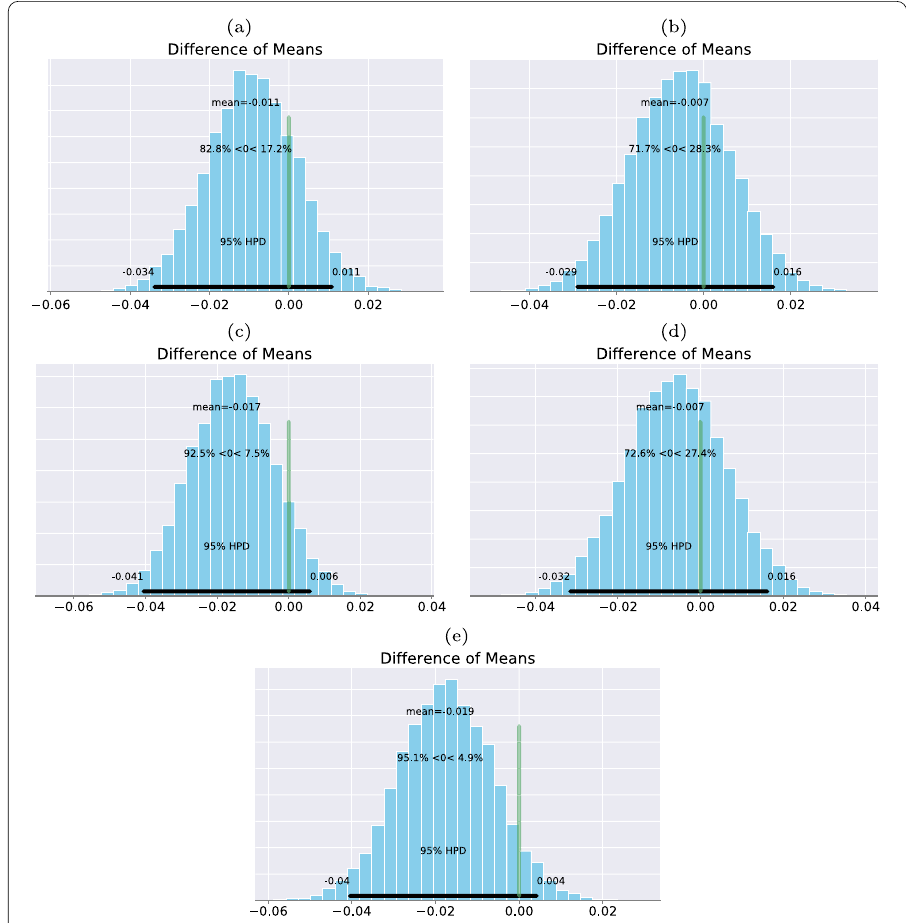
Figure 23 Posterior distributions and 95% credible intervals of differences for log loss scores from different methods. ( a ) Time Series Method Alone vs NLP NSC Method Alone. ( b ) NLP MNB Method Alone vs Time Series